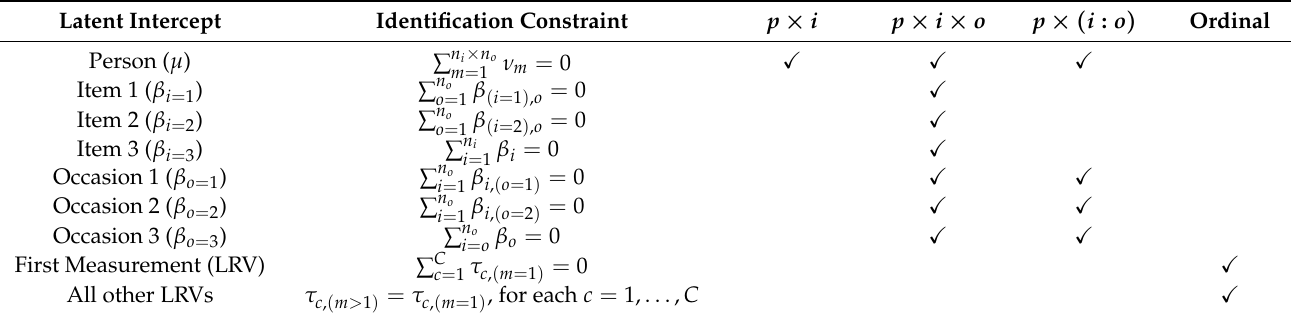
Table 1. Constraints required for mean-structure parameters to represent main and interaction effects among facets of